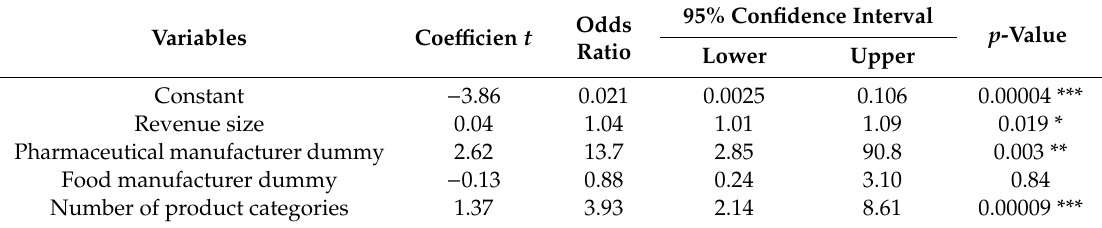
Table 3. Binomial logistic regression analysis of the adoption rate of GMP for dietary supplements with four independent